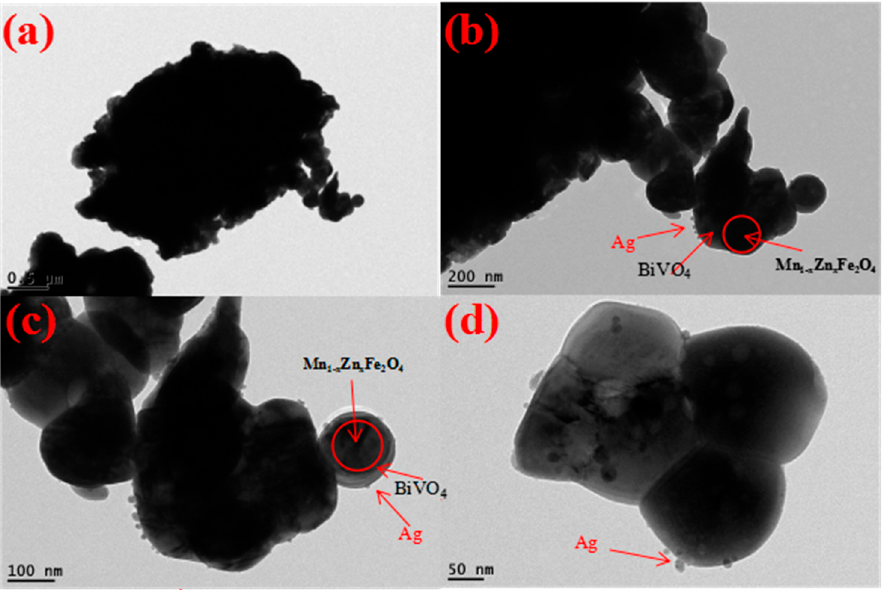
Figure 4. TEM images of Ag/BiVO 4 /Mn 1 − x Zn x Fe 2 O 4.